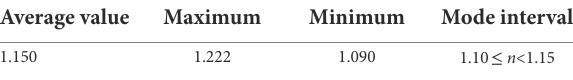
TABLE 5 Statistics of fractal dimension value of Urban Public Space Water Body. Average